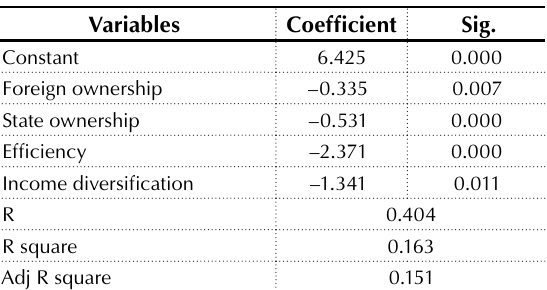
Table 2. The impact of ownership and characteristics on bank risk-taking behavior